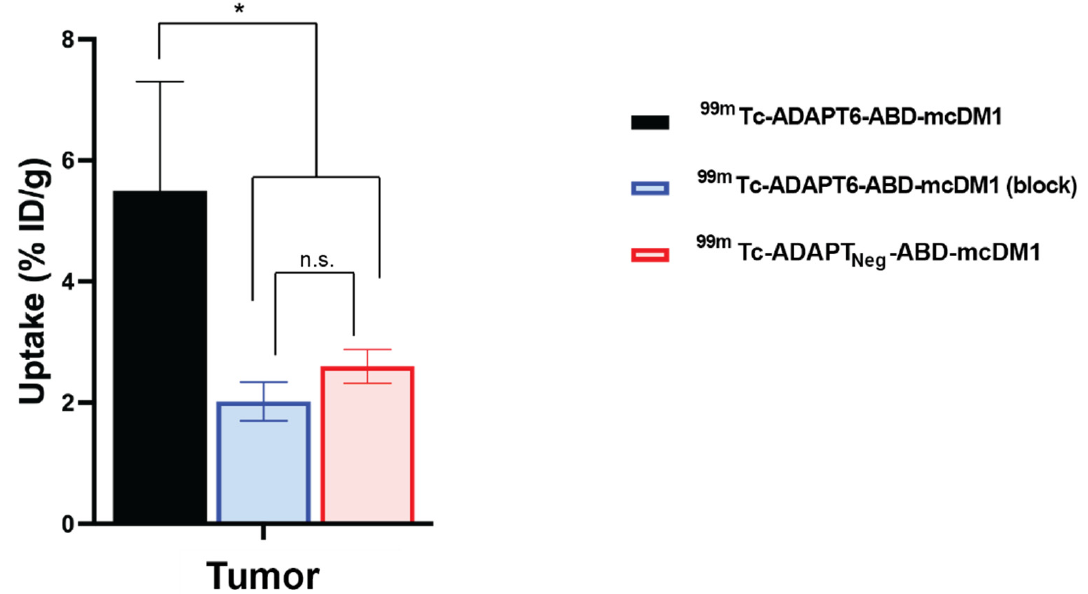
Figure 7. Specificity of targeting of HER2-expressing SKOV-3 xenografts using 99m Tc-ADAPT6-ABD-mcDM1. The uptake of radioactivity in the tumors at 24 h after injection of 99m Tc-ADAPT6-ABD-mcDM1 with pre-saturation with trastuzumab, 99m Tc-ADAPT6-ABD-mcDM1 (block), or without pre-saturation with trastuzumab, 99m Tc-ADAPT6-ABD-mcDM1, or after injection of the non-targeting control 99m Tc-ADAPT Neg -ABD-mcDM1. The radioactivity was calculated as percent of injected dose per gram tumor (% ID/g) and is presented as the mean value from four mice ± 1 SD. The tumor uptake of 99m Tc-ADAPT6-ABD-mcDM1 was significantly higher than the uptake of the same construct after blocking or the uptake of 99m Tc-ADAPT Neg -ABD-mcDM1. The significance indicator * corresponds to p < 0.05. n.s. (not significant) corresponds to p >